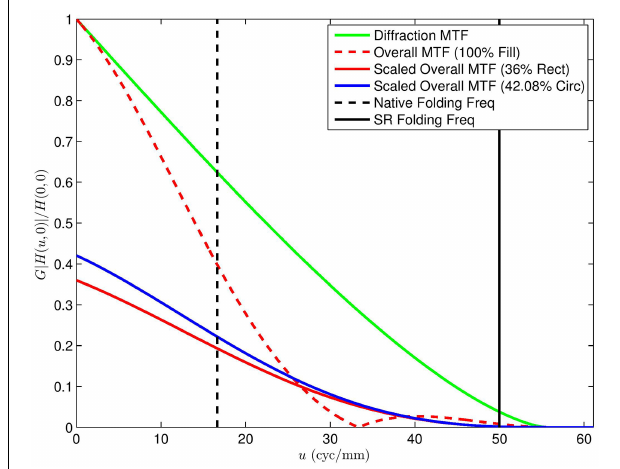
FIGURE 16 | Cross-section MTF plot similar to that in Figure 15, except here we have an f-number of F = 4 ( Q = 0 . 6 ) and L = 3 for SR. This represents the set up for the experimental results for the infrared imaging system in Section 5.2.